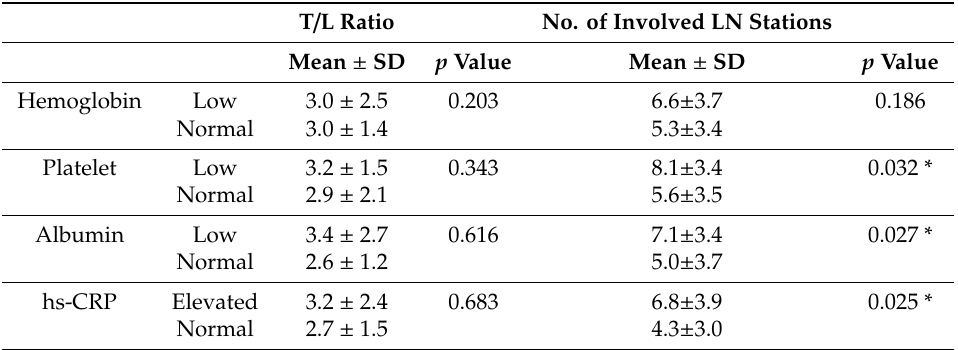
Table 5. Comparison of tumor-to-liver (T / L) ratios and number of involved LN stations with laboratory